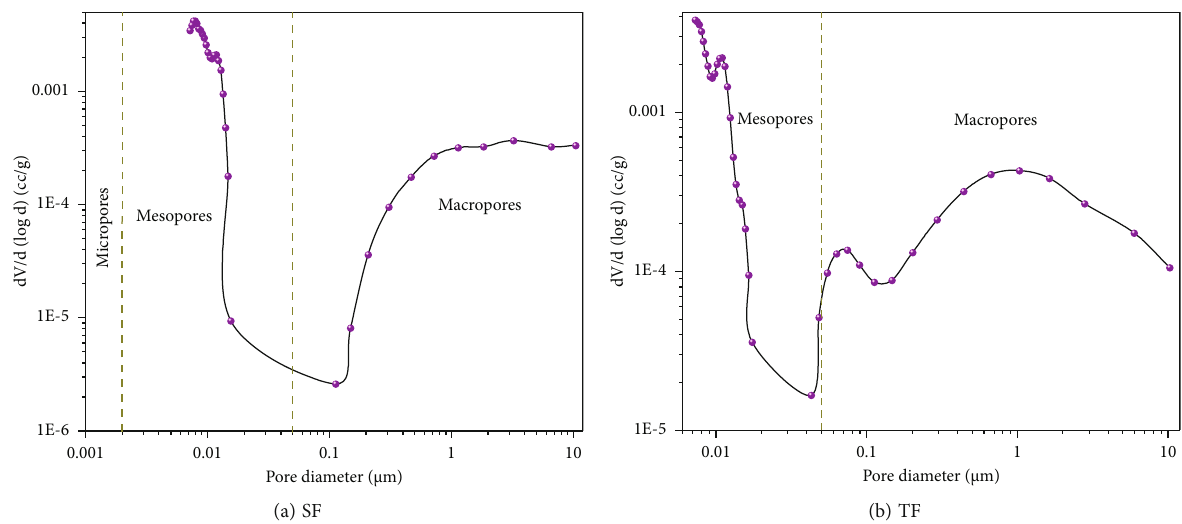
Figure 9: Showing the distribution of mesopores and macropores in the Shanxi Formation and Taiyuan Formation. (a) Distribution of mesopores and macropores in the Shanxi Formation. (b) Distribution of mesopores and macropores in the Taiyuan Formation.